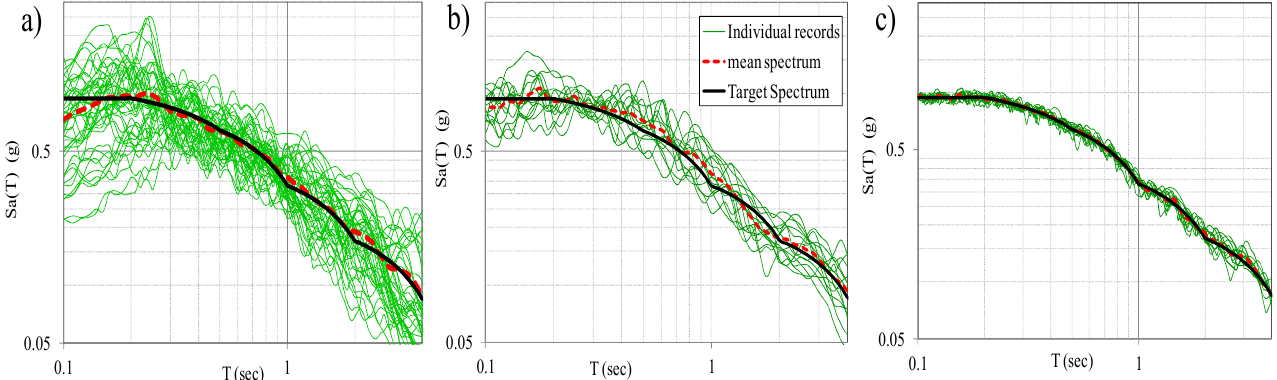
Figure 4. Response spectra for all records and mean response spectrum for the case of: ( a ) natural records; ( b ) Atkinson records; and ( c ) SIMQKE records.